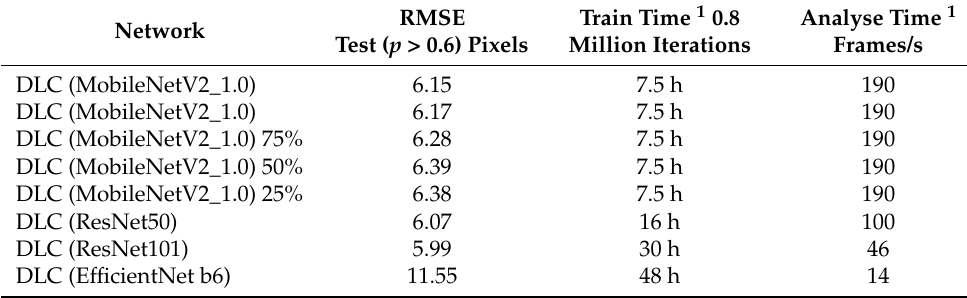
Table 5. Root mean square error scores on test set and times for training. RMSE Train Time 1 0.8 Network Test ( p > 0.6) Pixels Million Iterations